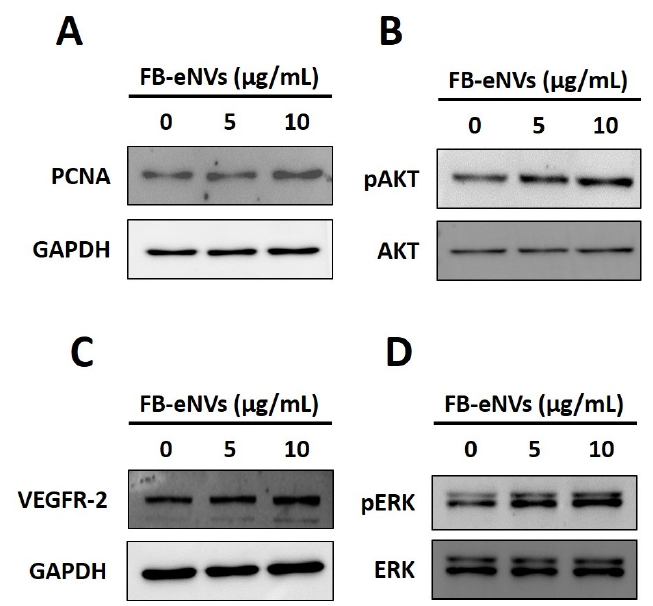
Figure 6. FB-eNV treatment modulated signaling pathways in DP cells. ( A – D ) Western blot analysis of PCNA, pAKT, AKT, VEGFR-2, pERK, ERK, and GAPDH levels in DP cells after 24 h of treatment with FB-eNVs.